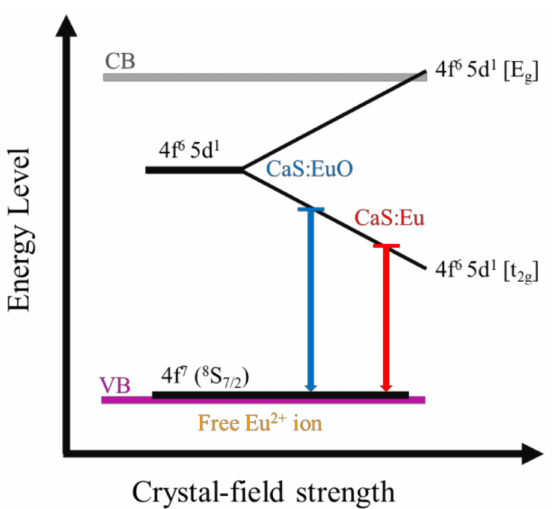
Figure 7. Schematic energy diagram of Eu 2+ 5d level splitting as function of crystal-field strength in CaS:Eu and CaS:EuO